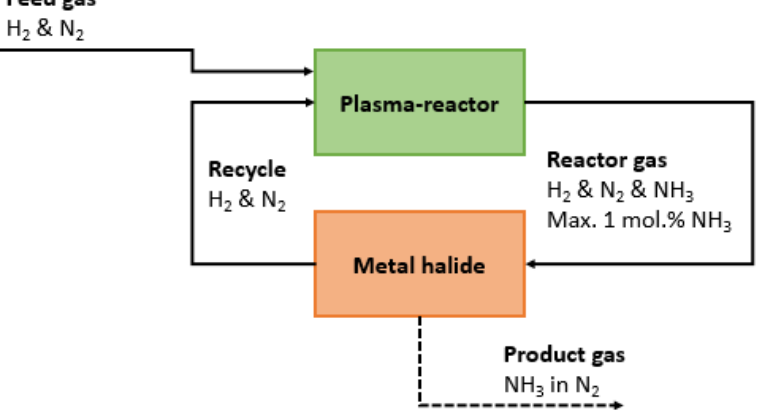
Figure 7. Process scheme of a plasma-catalytic ammonia synthesis loop.